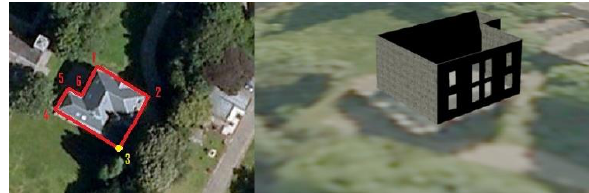
Figure 5: Screenshot of the 3D visualisation of a building The results of the exercise have to be explained in a detailed report, as well as in an oral presentation. These should cover the used